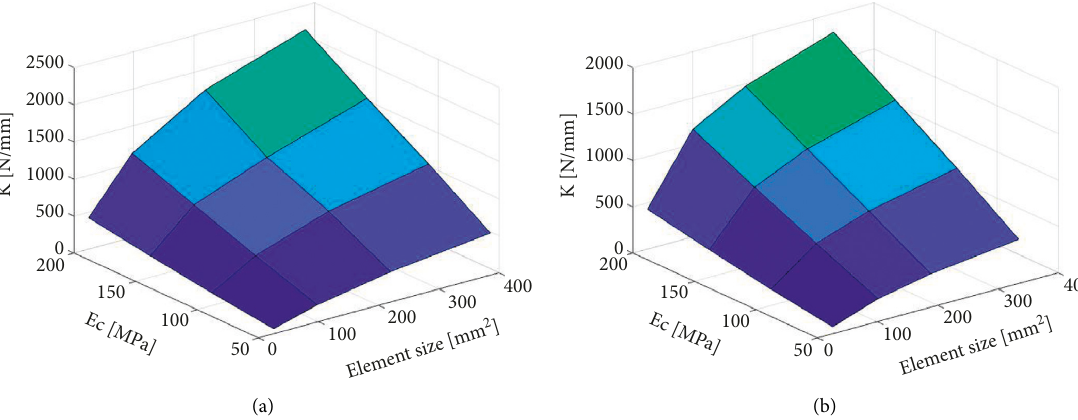
Figure 13: The 3D curve of K as a function of E